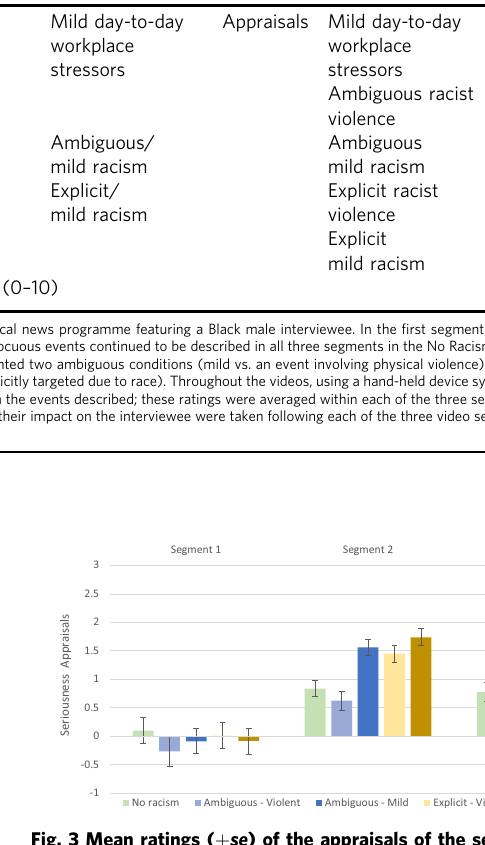
Fig. 3 Mean ratings ( + se ) of the appraisals of the seriousness of the impact of the events on the interviewee as a function of racist cues ( fi ve conditions) described over the three video segments. The presence of either mild ambiguous or explicit racist cues in Segment 2 resulted in perceiving the situation as having a more serious negative impact on the target. In Segment 3, the explicit racism conditions were perceived to have a greater impact on the target compared to when racism was ambiguous, with the combination of explicit racism and violence being appraised as having a particularly events were not signi fi cant, t (205) = 0.21, p = 0.831, the combi-